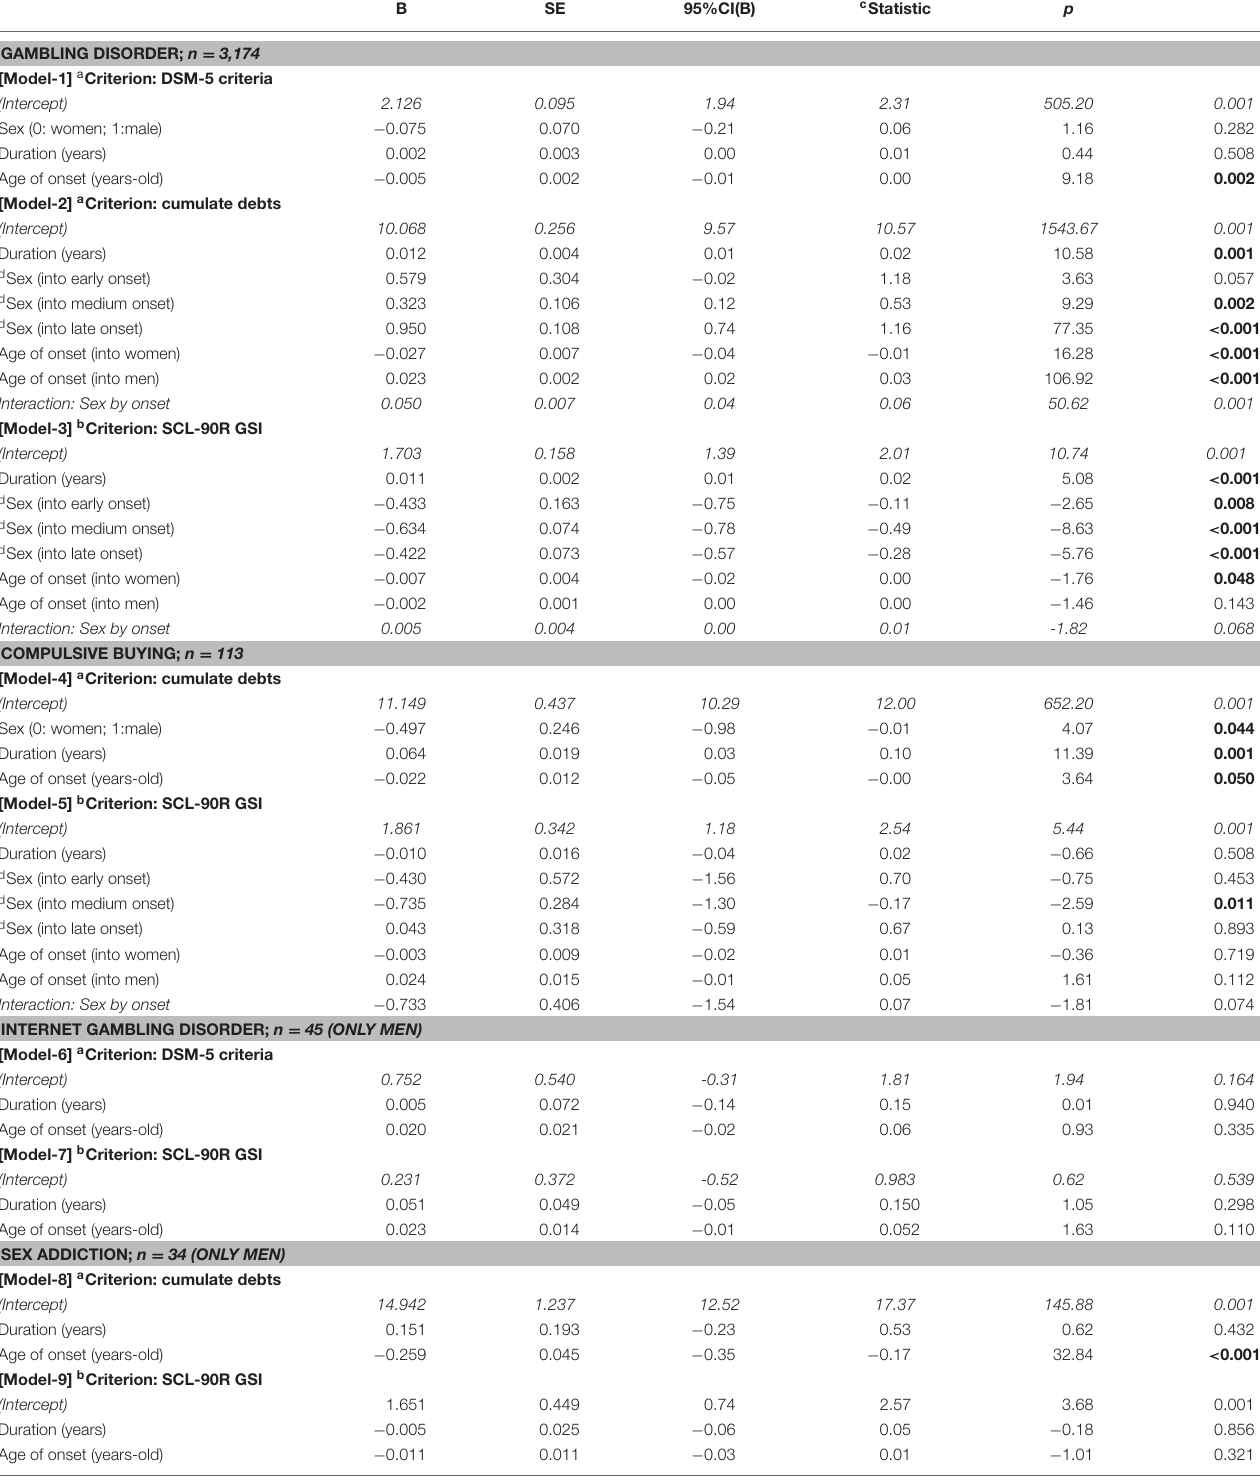
a Negative-binomial regression. b Linear multiple regression. c Wald-chisquare for negative-binomial regression and T for linear regression. d Due to the relevant interaction sex by onset, single effects for the sex were obtained into three groups defined by the age of onset: early (onset before 20 years-old), medium